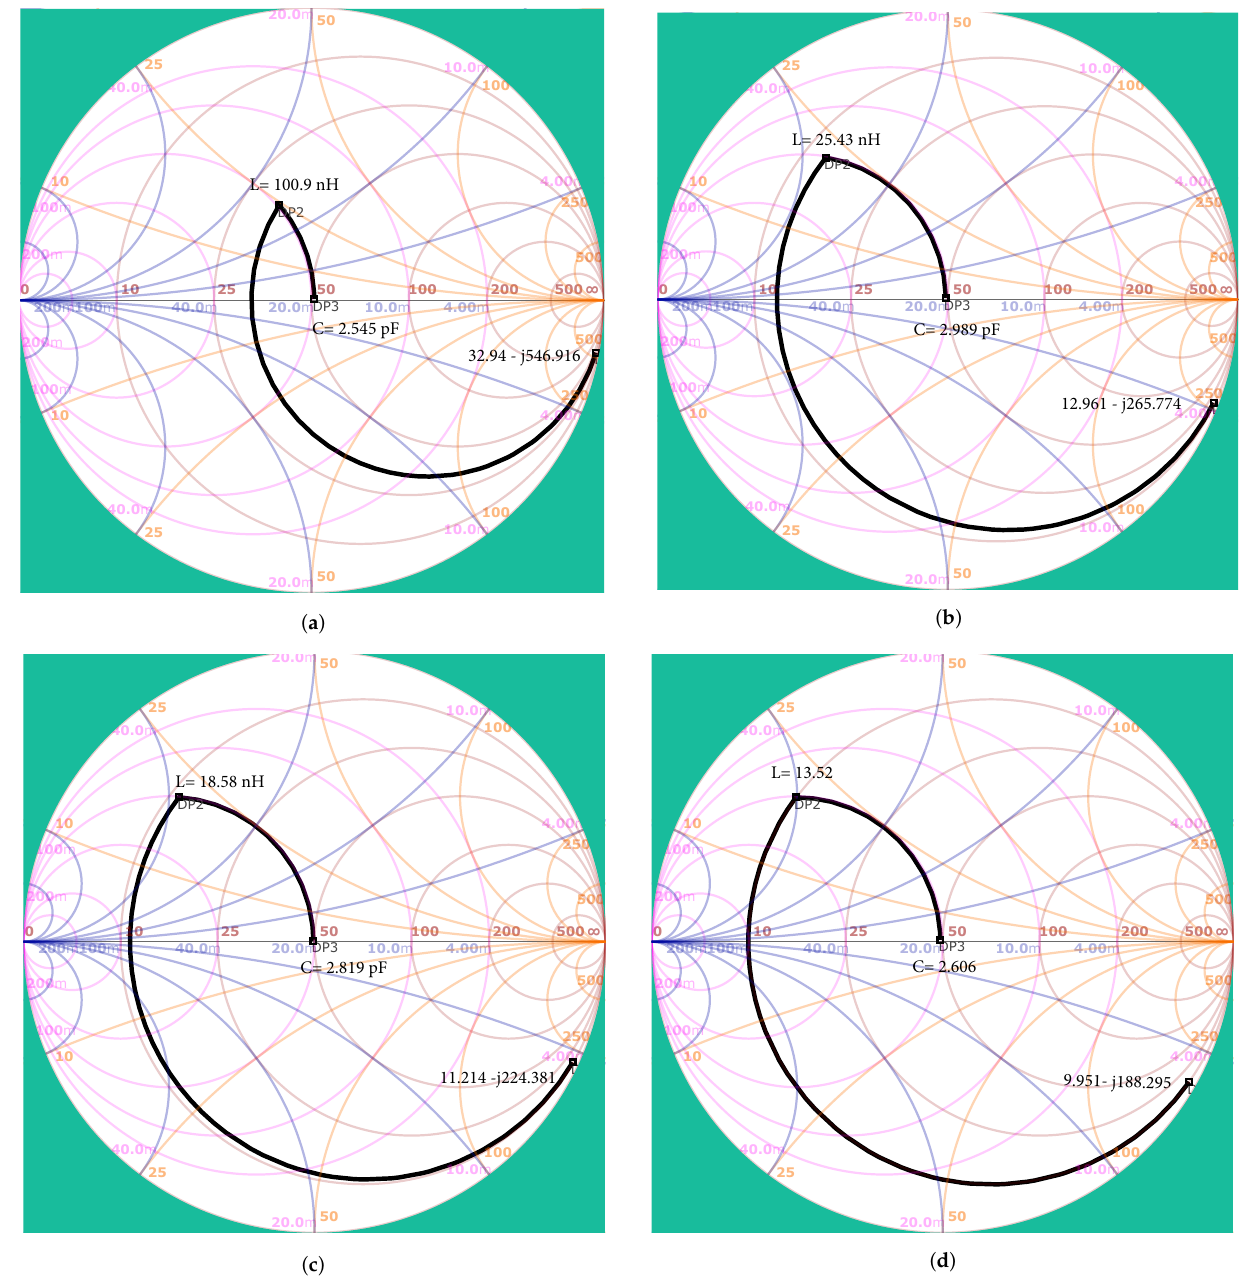
Figure 5. Smith chart for single-bands. ( a ) GSM-900. ( b ) GSM-1800. ( c ) UMTS-2100. ( d ) Wi-Fi 2.45. Reflection Coefficient plotted on a polar axes: The lengths of the transmission line sections are found as follows [75]: